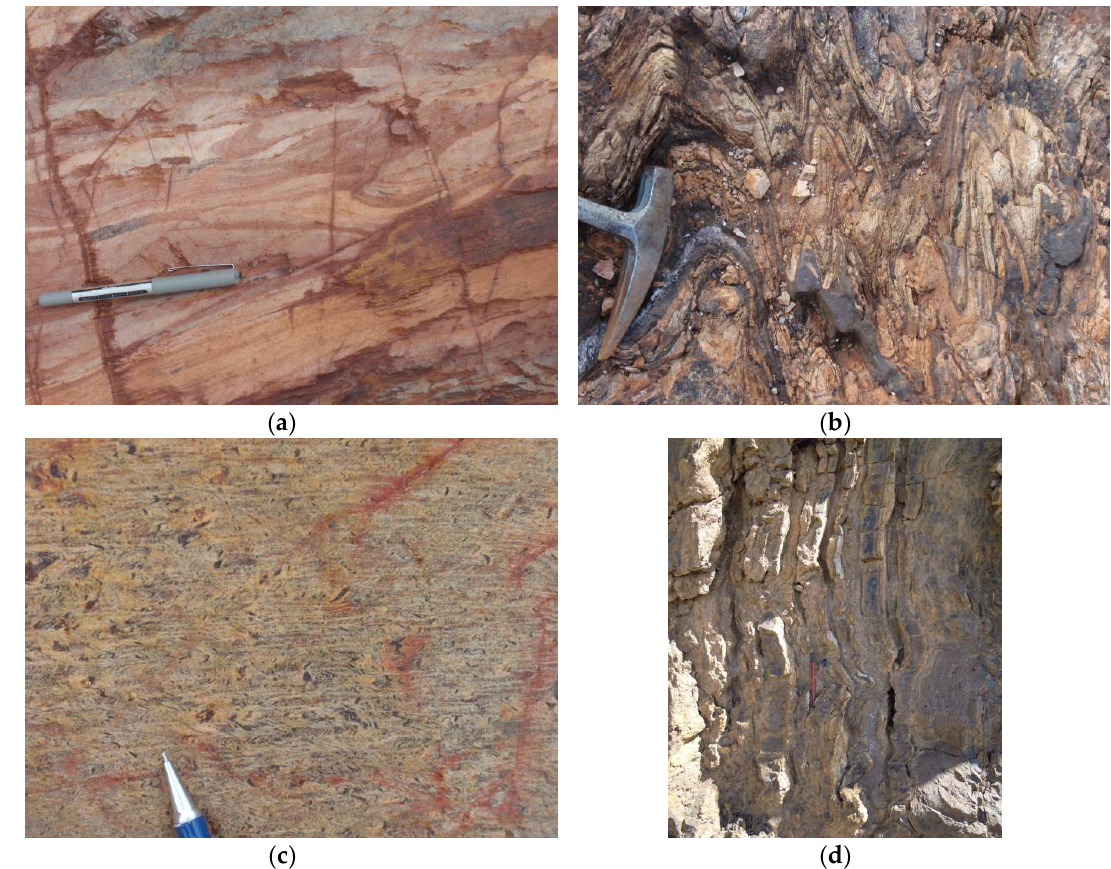
Figure 7. Examples of fold structures in the central Kukuluma terrain: ( a ) Ductile, flame-like isoclinal folds in turbiditic greywacke, interpreted as folding associated with fluidization during D 1 ; ( b ) Tight D 3 vertical folds in ironstone in the southwest Matandani pit; ( c ) Close up of S 3 spaced crenulation cleavage in shale; ( d ) Open recumbent D 5 folding in chert bands.